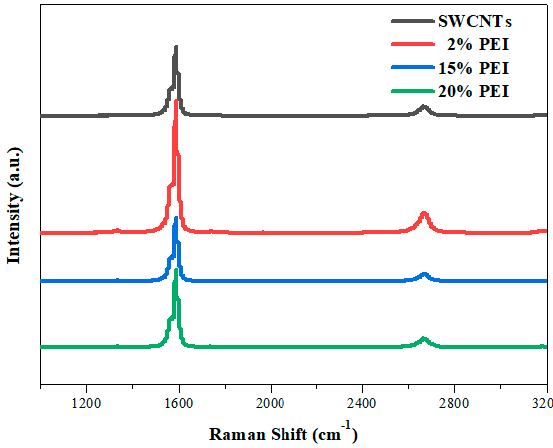
Figure 3. Raman spectra of pristine SWCNTs and PEI-doped SWCNTs.